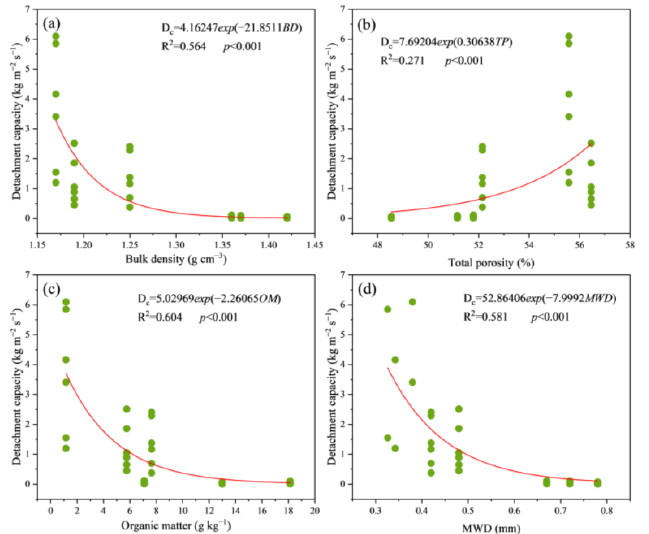
Figure 6. Relationship between soil detachment capacity and soil bulk density ( a ), soil porosity ( b ), organic matter ( c ), and aggregate stability (( d ), MWD).